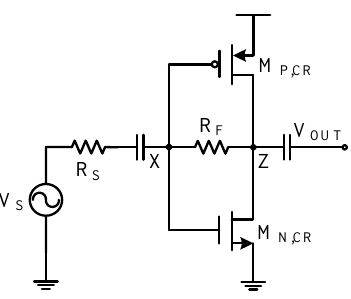
Figure 9. Current-reuse resistive shunt-feedback amplifier.